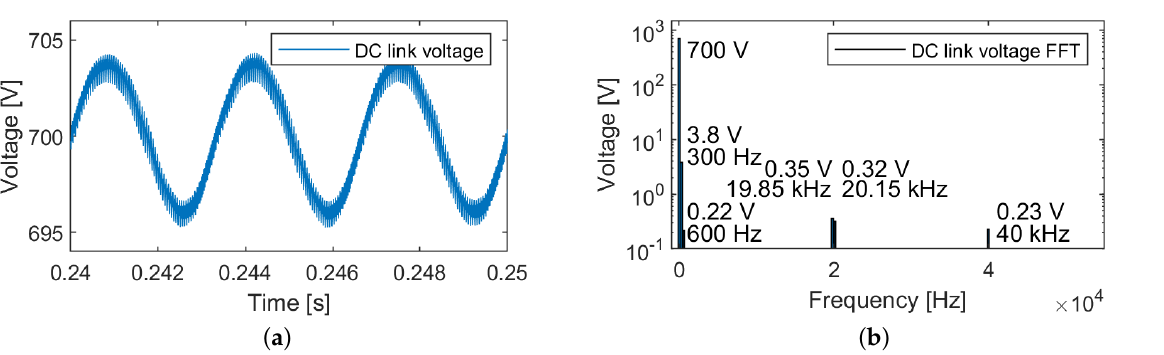
Figure 18. Three-phase three-level T-type rectifier simulation results. ( a ) DC link voltage. ( b ) DC link voltage harmonic